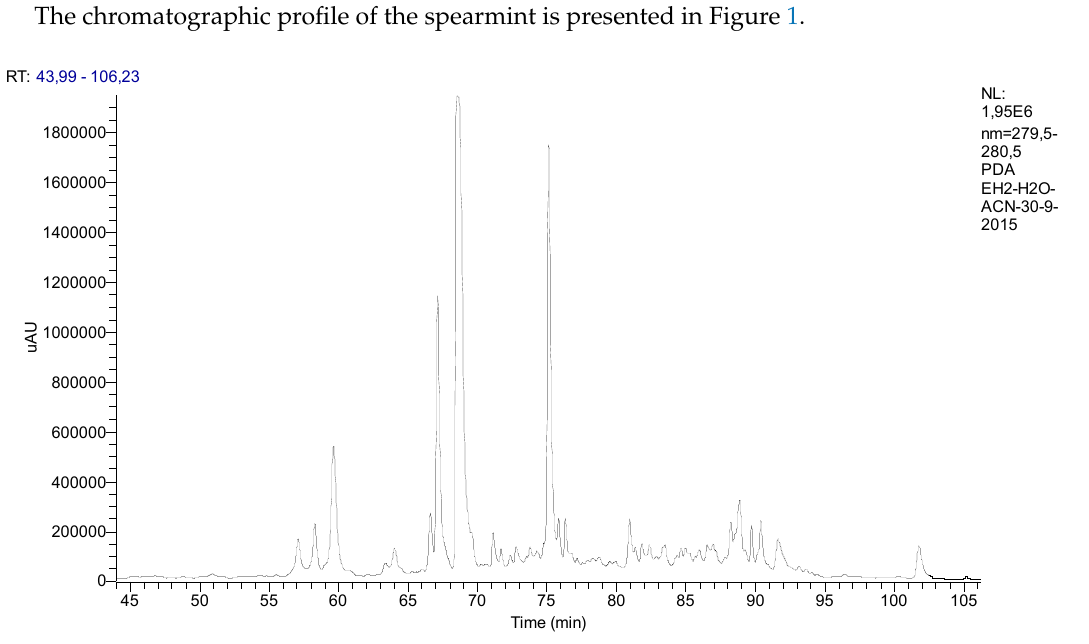
Figure 1. Chromatographic profile of the Mentha spicata L. extract with identification of its phenolic components classified according to their functional groups.